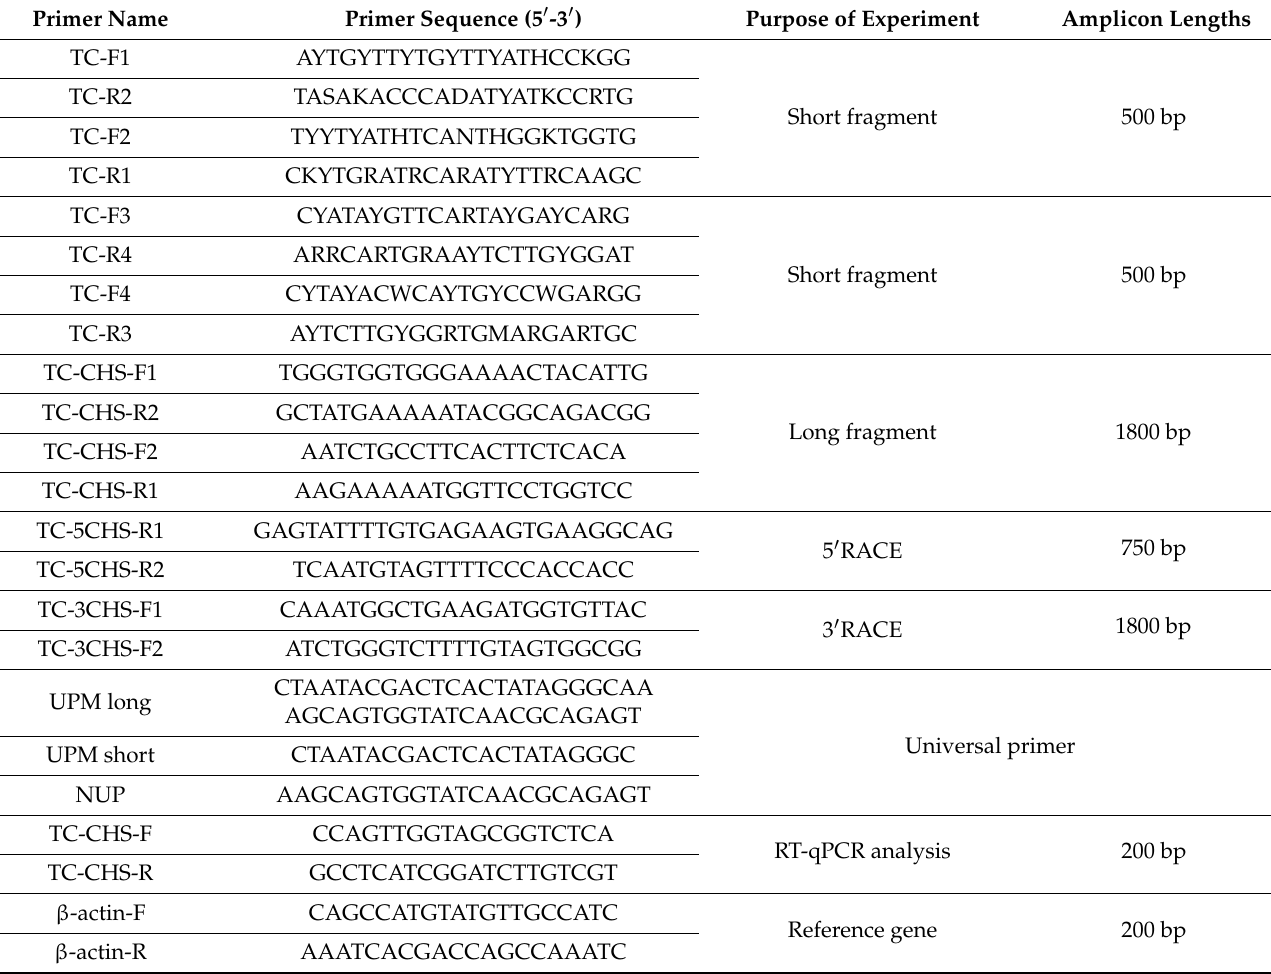
Table 1. Primers and their sequences used in the present